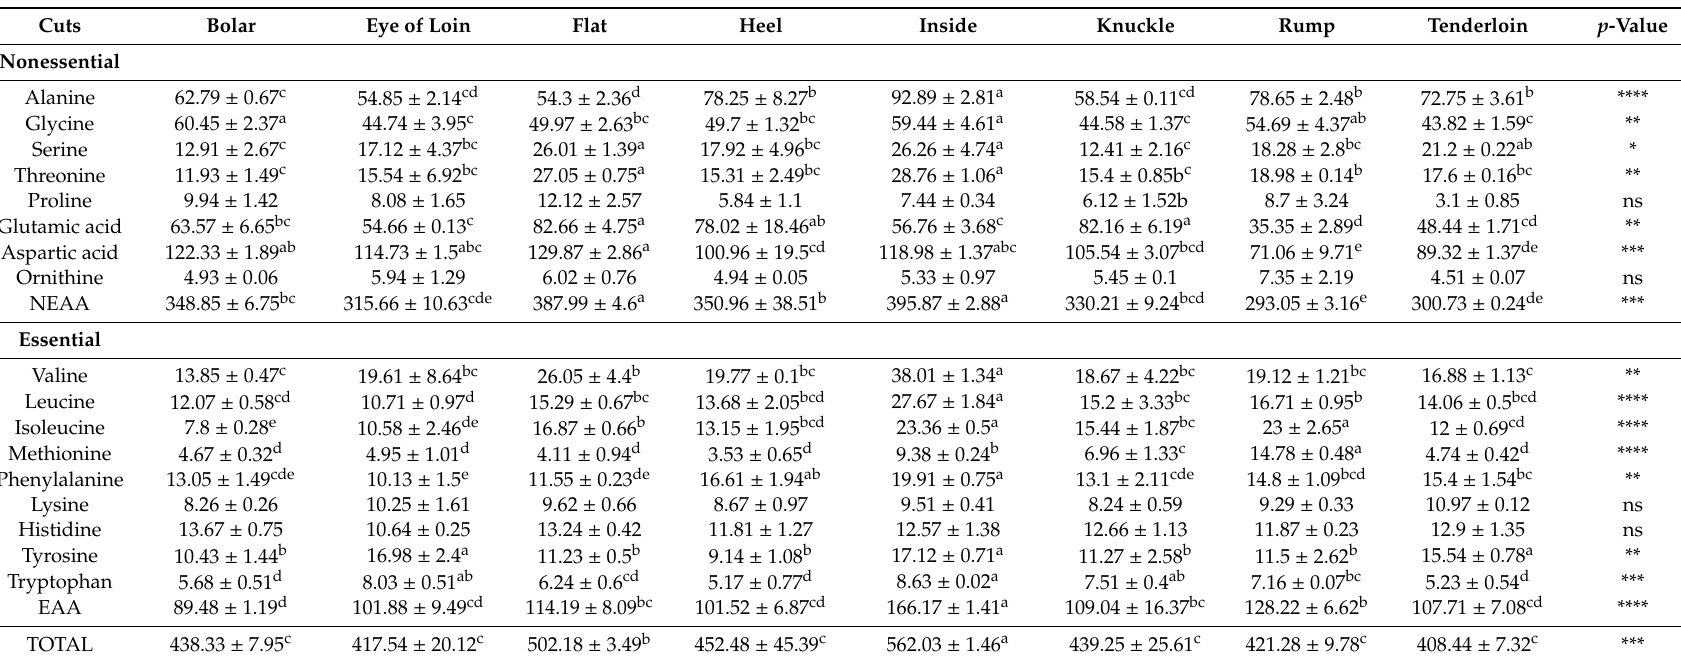
Table 2. Free amino acid composition (mg / 100g) in di ff erent New Zealand lamb meat